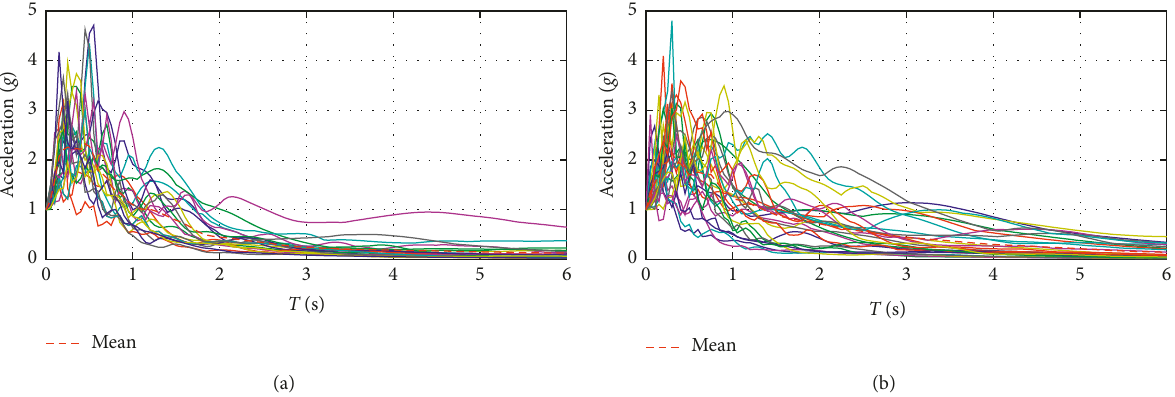
Figure 18: (a) Far-field and (b) near-field seismic wave response spectra.